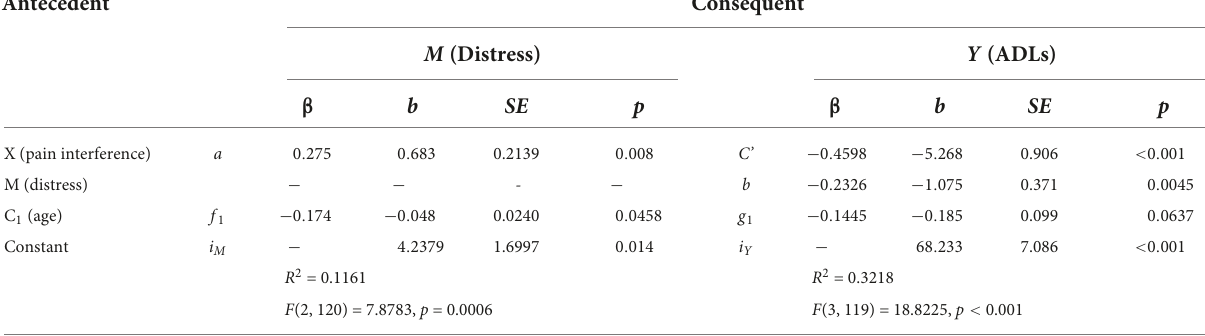
TABLE 7 Model coefficients for the pain interference, distress, ADLs simple mediation model with covariate of age. Antecedent